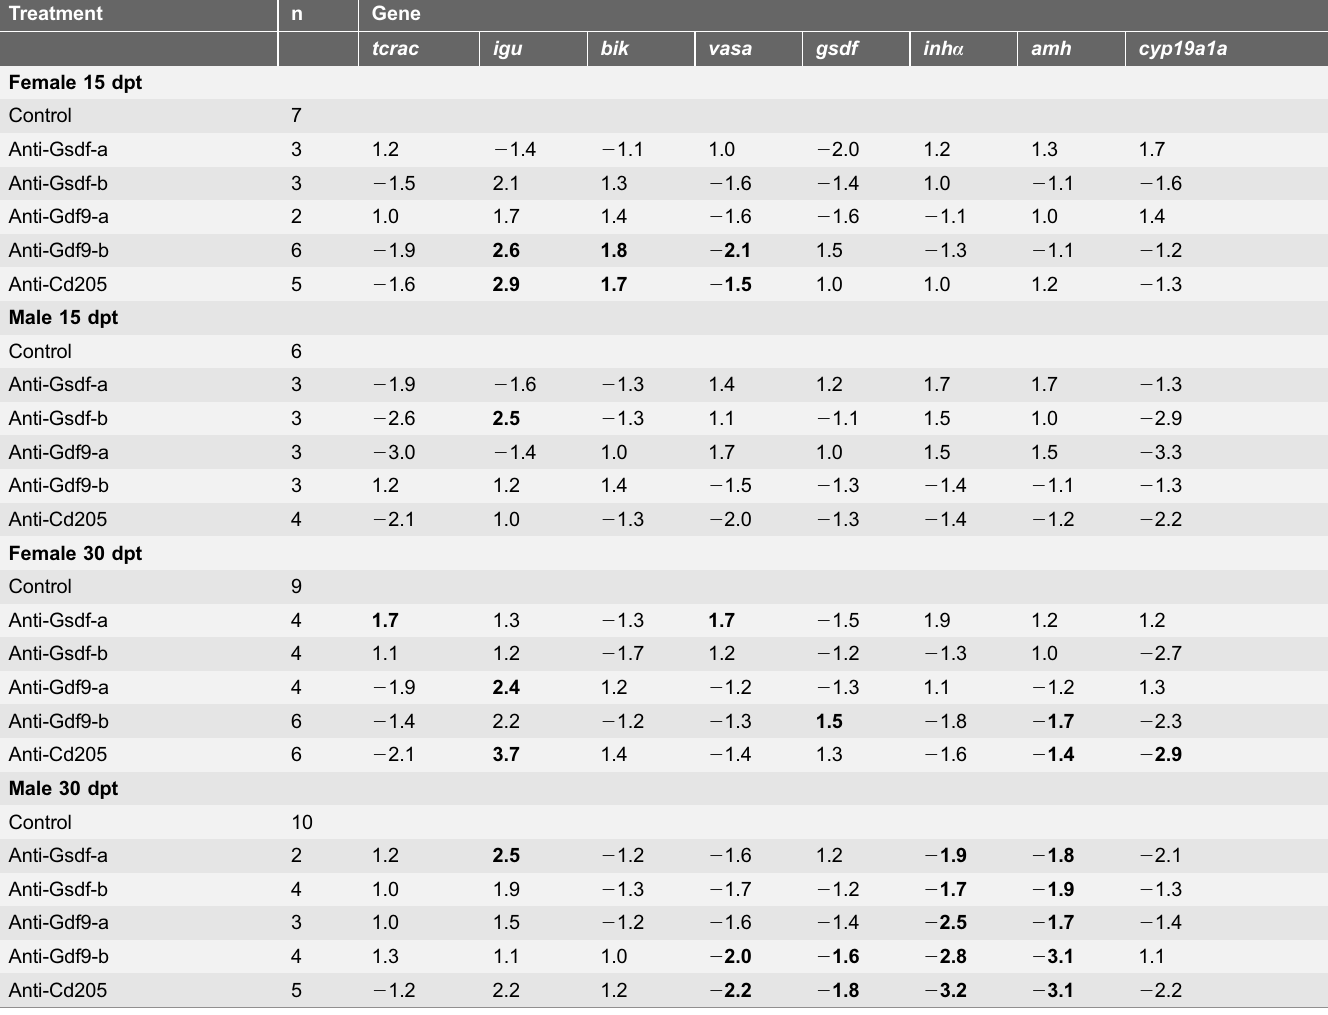
Table 3. Expression of marker genes at 15 and 30 days post treatment